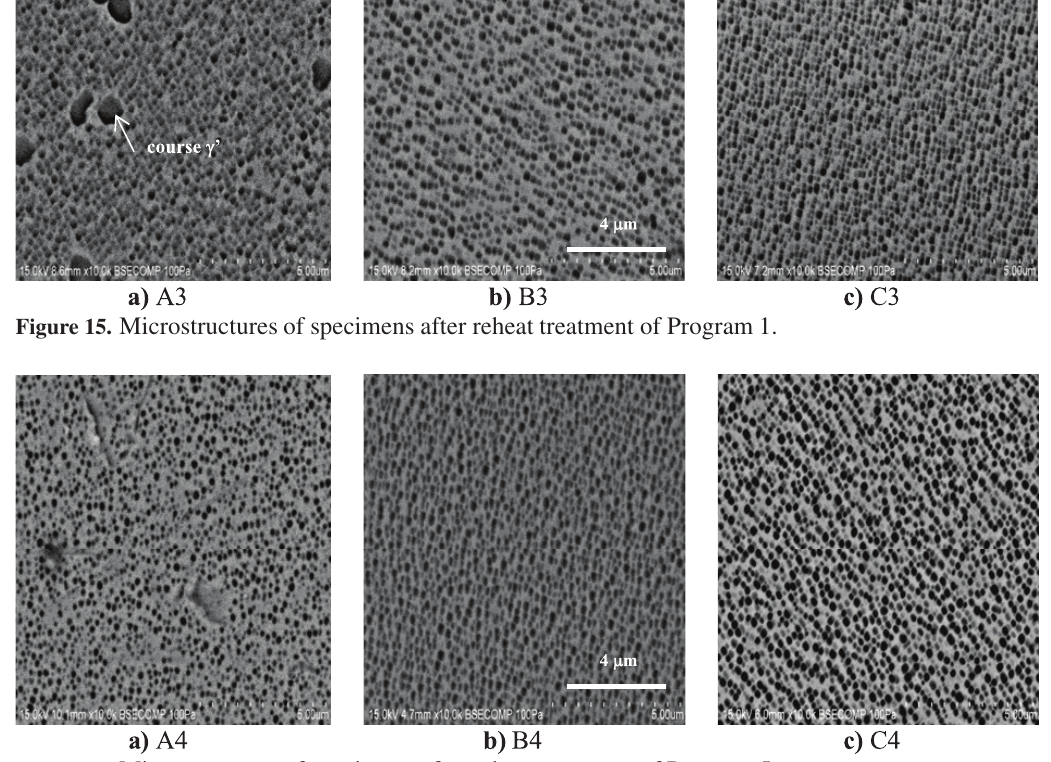
Figure 16. Microstructures of specimens after reheat treatment of Program 5.